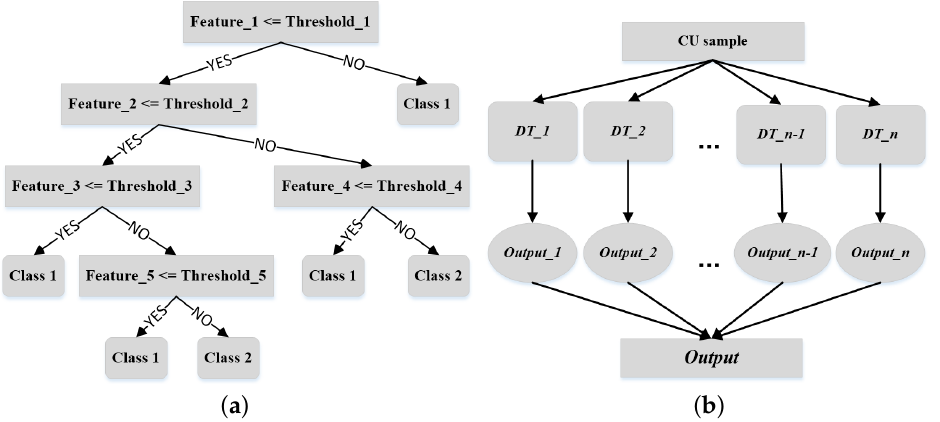
Figure 2. Structures of decision tree and bagged tree. ( a ) a simple structure of a decision tree, in which Feature_n represents the n th feature and Threshold_n is the corresponding threshold to make a decision. Each leaf node represents a class label and each father node represents a judging process. ( b ) a structure of bagged tree model. n is the number of decision trees used to make up a bagged tree, and DT _ n presents the n th decision model among them. Output _ n is the output of the n th decision tree model, and it is used to calculate the final output of bagged